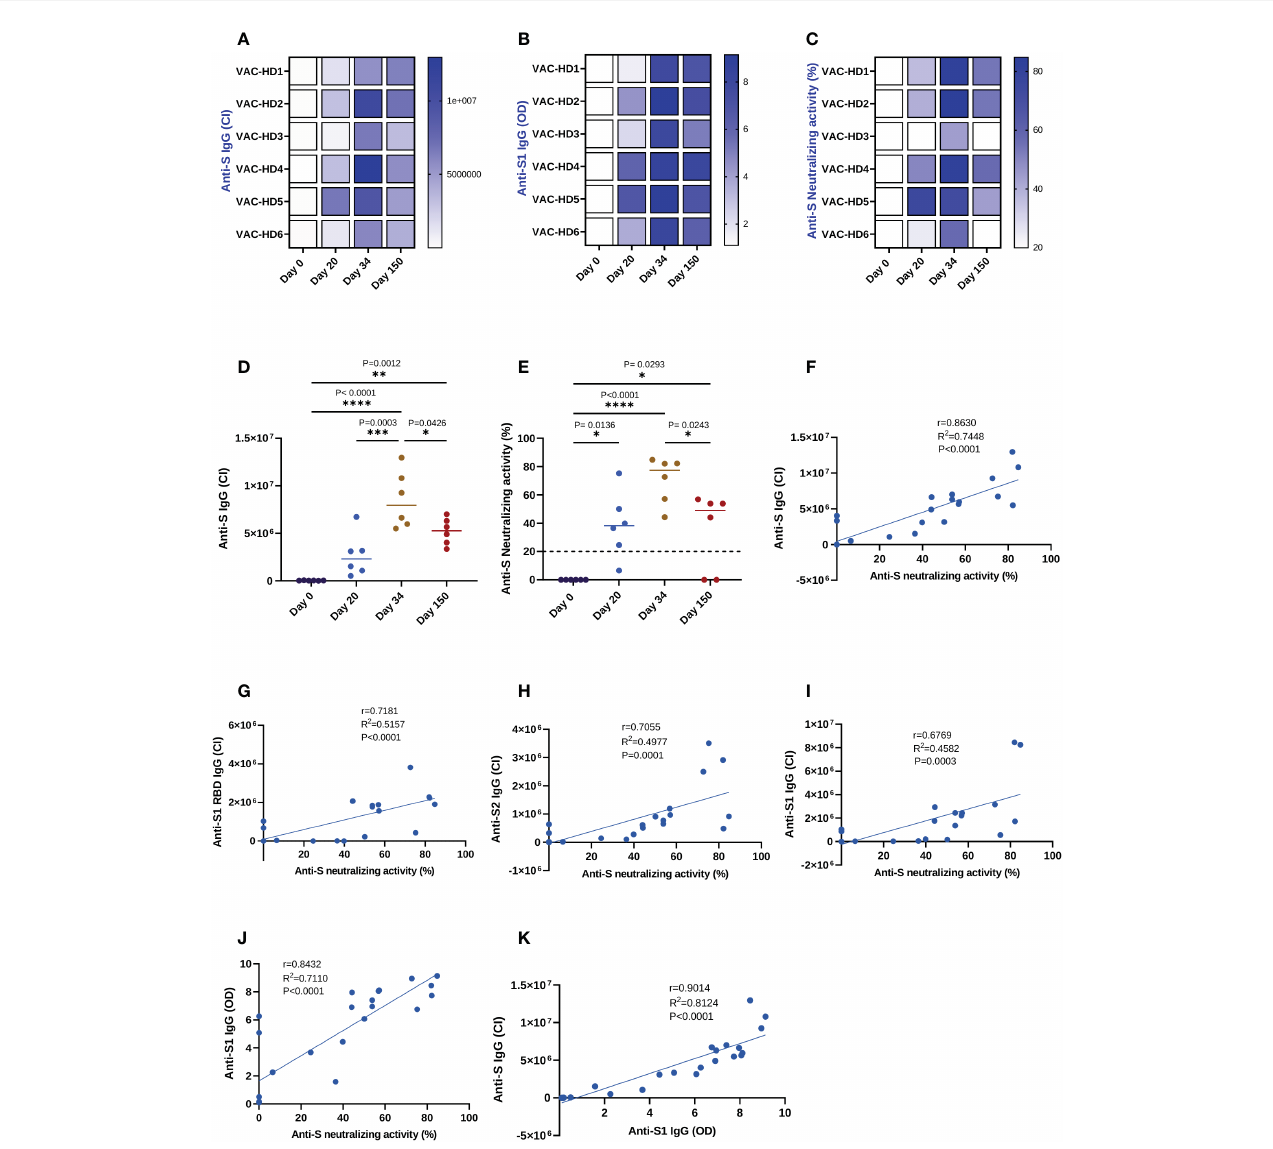
FIGURE 2 Correlation between the anti-spike binding and neutralizing antibodies responses induced by BNT162b2 vaccination and detected by three different immunoassays. Serum samples were collected from six BNT162b2 vaccinated participants at the baseline, 20-, 34-, and 150-days post-vaccination. The anti-S and anti-S1 IgG levels were assessed using Jess and ELISA, respectively. The anti-S neutralizing activity was measured using the neutralization assay. (A – C) Heat-map of anti-S IgG, anti-S1 IgG, and anti-S neutralizing activity responses in six BNT162b2 vaccinated participants over time. (D) Dynamics of the anti-S IgG levels in six BNT162b2 vaccinated participants over time (Jess). (E) Dynamics of the anti-S neutralizing activity in six BNT162b2 vaccinated participants (Neutralization assay). Each symbol represents an individual participant with a line indicating the median of each time point. One-way ANOVA test was used, P value was considered statistically signi fi cant when *P ≤ 0.05. All samples were run in duplicates. (F – I) Correlation between anti-S, S1 RBD, S2, and S1 IgG levels detected by JESS and neutralizing activity, respectively. (J) Correlation between anti-S1 IgG levels detected by semi-quantitative ELISA and neutralizing activity. (K) Correlation between anti-S1 IgG levels detected by ELISA and anti-S IgG levels detected by JESS. All correlations were analyzed by Pearson statistical test and linear regression models. The scatter point represents serum samples (n=24) collected from six BNT162b2 vaccinated participants at the baseline, 20-, 34-, and 150-days post-vaccination, and the blue error band represents the 95% con fi dence interval. The coef fi cient of correlation (r) represents the strength of the linear relationship between the different immunoassays. The coef fi cient of determination (R2) represents the percentage of variance in the given data set. The P-value tests whether the regression equation is signi fi cant. P value was considered statistically signi fi cant when *P ≤ 0.05. The stars present the level of signi fi cance. *P < 0.05; **P < 0.01; ***P < 0.001; ****P <